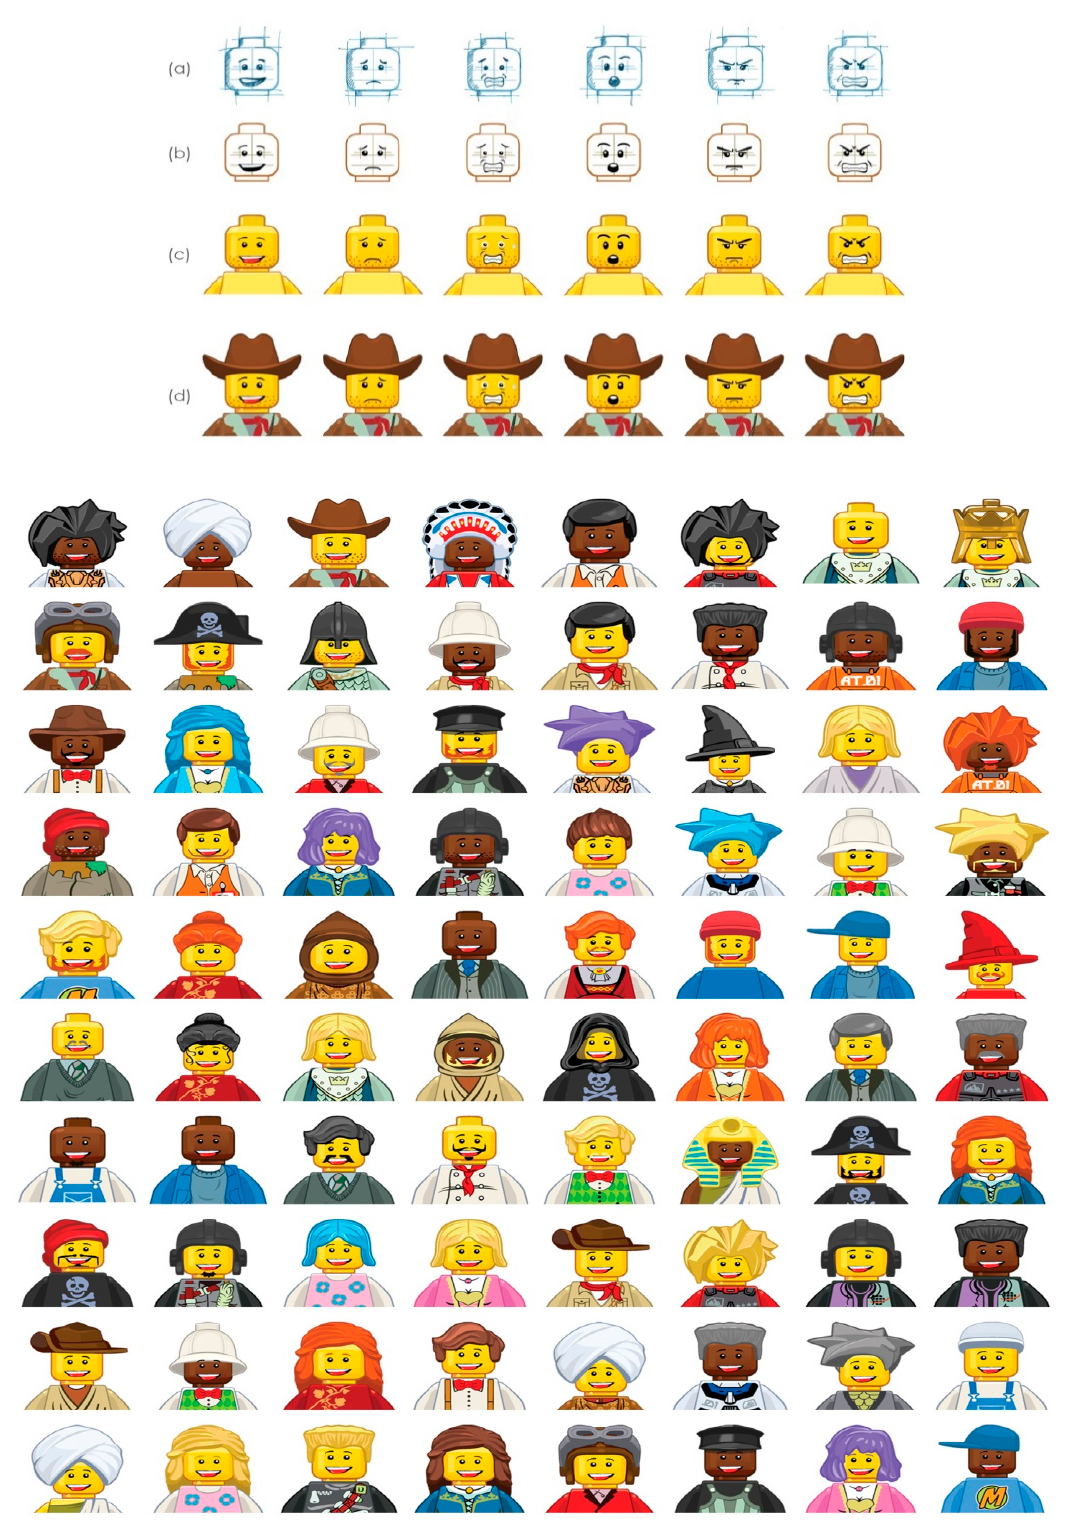
Figure 1. Facial expression design process: happiness, sadness, fear, surprise, disgust, and anger. ( a ) Pencil sketches. ( b ) Vector illustrations. ( c ) Minifigures for user testing. ( d ) Final characters.